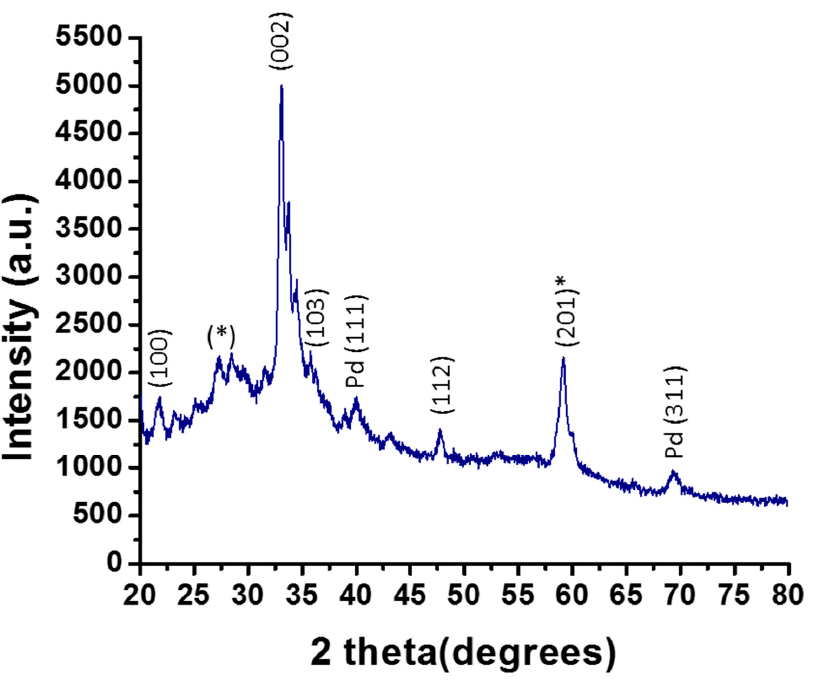
Figure 1. XRD pattern of ZnO-Pd nanosheet biosynthesis ( ٭ -the reflections present in the ZnO-Pd nanosheets, which may have been caused by the residual moieties of the leaf extract).